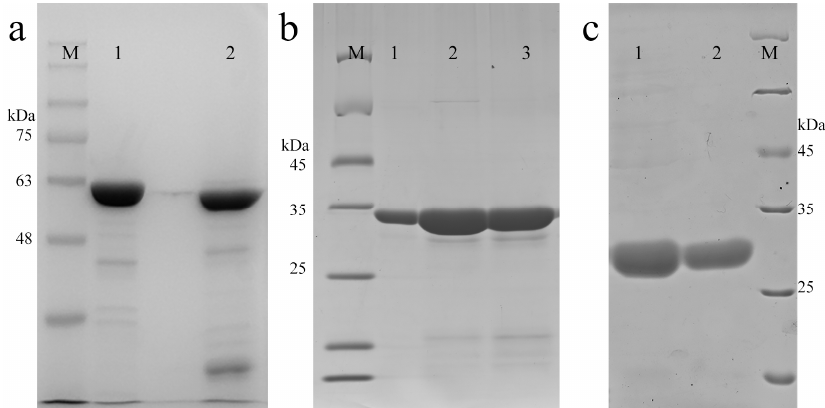
Figure 3. SDS-PAGE of purified proteins. ( a ) 10% SDS-PAGE of protein EwtA5 (lane 1) and EctA5 (lane 2). ( b ) 12% SDS-PAGE of protein wtA5. Lane 1: anxA5 standard; lane 2: flow through after cleavage of IwtA5; and lane 3: purified protein after buffer exchange. ( c ) 12% SDS-PAGE of protein ctA5. Lane 1: flow through after cleavage of IctA5; lane 2: purified protein after buffer exchange. M, protein marker.